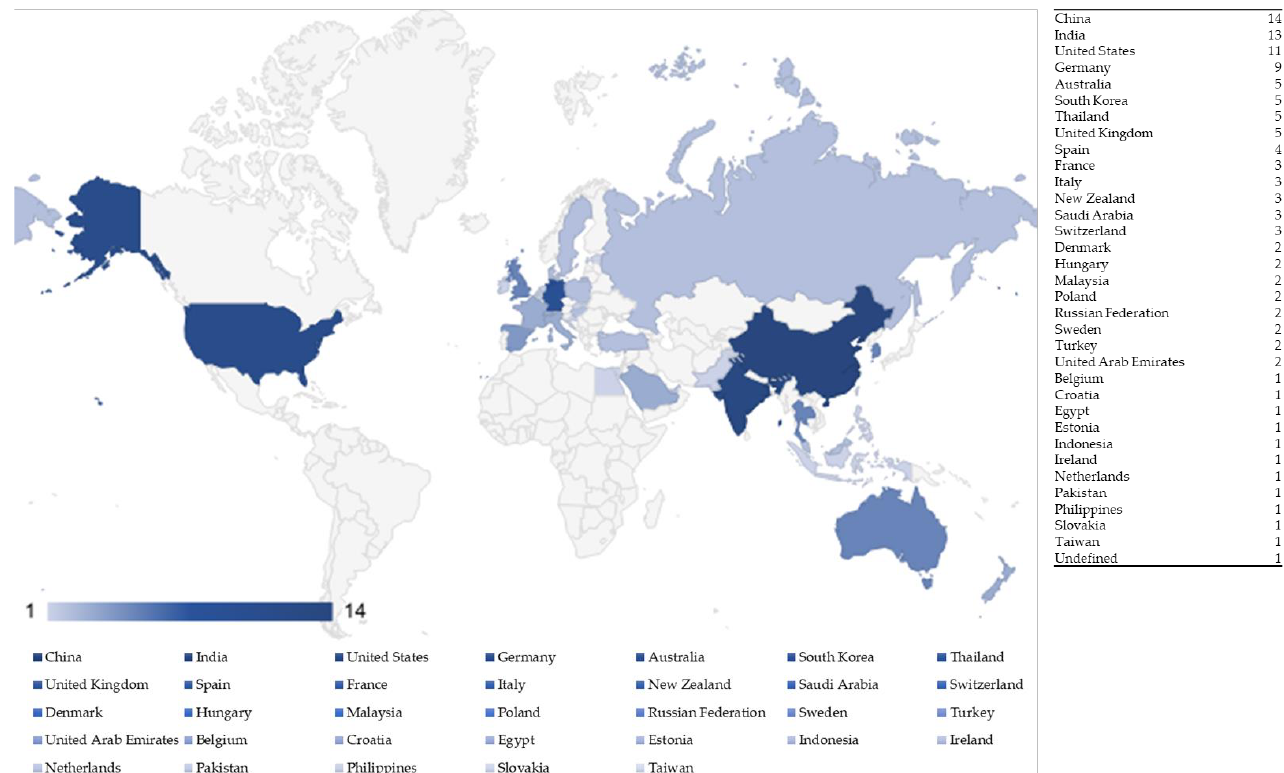
Figure 5. The distribution of authors by country.